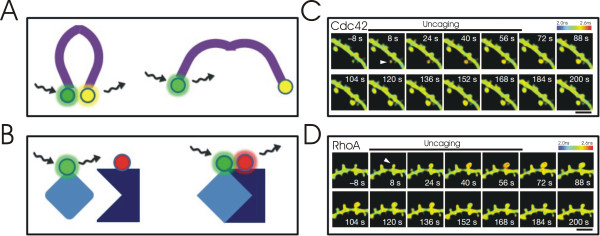
FRET/FLIM-based reporters of synaptic signaling. (A) FRET/FLIM-based systems use a donor and acceptor fluorophore to monitor conformational changes within a protein. One such system, which reports CAMKII activity, uses monomeric enhanced GFP (mEGFP) for the donor fluorophore and a variant of YFP for the acceptor fluorophore; the fluorophores are fused, respectively, to the N- and C-terminal tail of the protein. The conformational change that accompanies CAMKII activation increases the distance between the closely apposed N- and C-terminal tails, resulting in a reduction of FRET (YFP/mEGFP fluorescence) and an increase in the fluorescence lifetime of mEGFP; either measure can be used to monitor CAMKII activity. (B) FRET/FLIM based systems can also be designed to report protein-protein interactions. One such system, which reports Ras activation, uses a donor fluorophore (mEGFP) fused to the Ras protein and an acceptor fluorophore (mRFP) fused to a Ras-binding domain; when active, Ras binds to the Ras-binding domain, and the co-localization of the mRFP and mGFP fluorophores results in an increase of FRET (mRFP/mGFPfluorescene), and a decrease in the fluorescence lifetime of mGFP. (C) LTP induction at single spines (arrow head) by repetitive glutamate uncaging (t = 0) is associated with a sustained activation of Cdc42, which remains restricted to the spine and (D) RhoA, which diffuses away from the spine (<10 μm). Figure 5C,D: Reprinted by permission from Macmillan Publishers Ltd: [NATURE] (Murakoshi et al., 472(7341):100-4) copyright (2011).